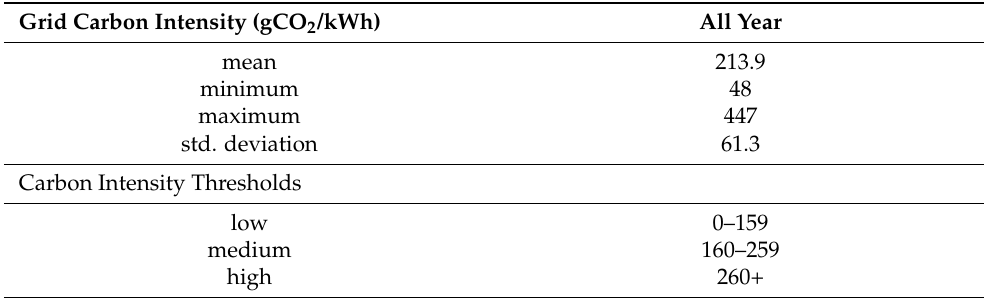
Table 10. UK energy grid carbon intensity (2019) and carbon intensity